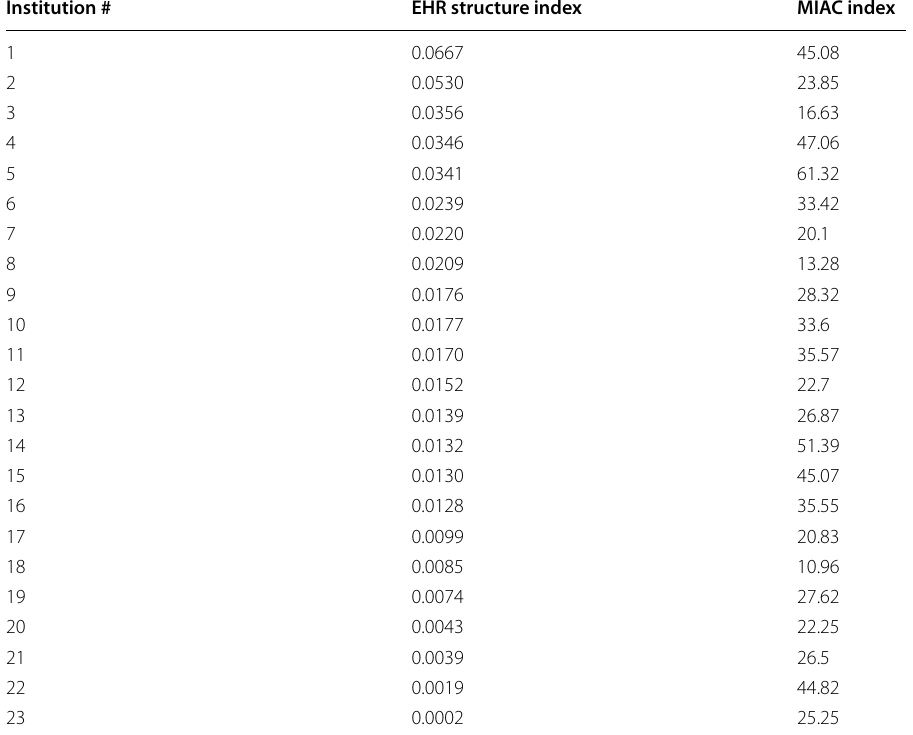
Table 7 Overall rating of healthcare facilities by the EHR structure index in comparison with the MIAC